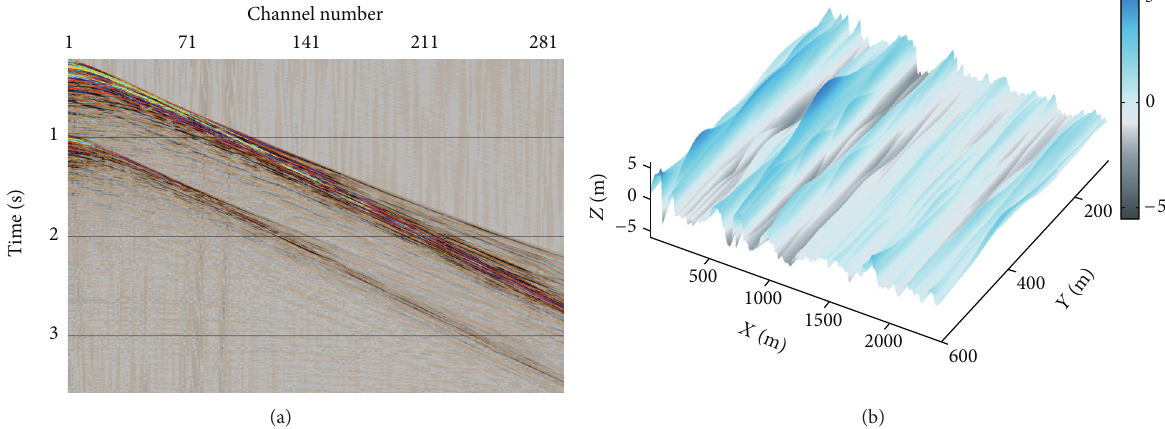
Figure 9: (a) A shot record of the measured total pressure wavefield at 20m depth for the outermost streamer and (b) the imaged sea surface taken from the area around the primary